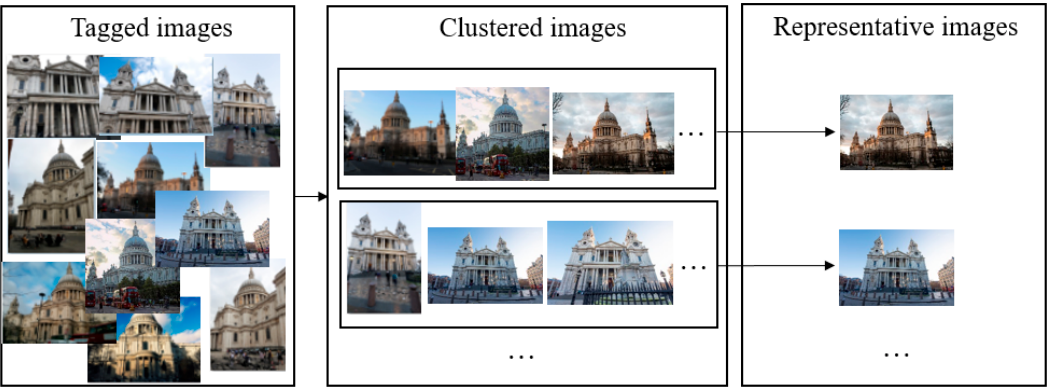
Figure 5. Workflow of representative-building-image selection.